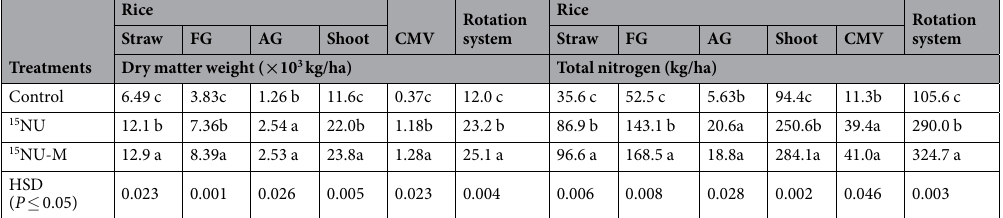
Table 1. Biomass and total N uptake in shoots of rice and CMV plants. 15 NU: 15 N-labeled urea as FN alone, 15 NU-M: substituting partial 15 N-labeled urea with CMV as GM. FG: filled grain, AG: abortive grain. Different letters within the same column indicate significant differences among treatments according to Tukey’s test at P ≤ 0.05.